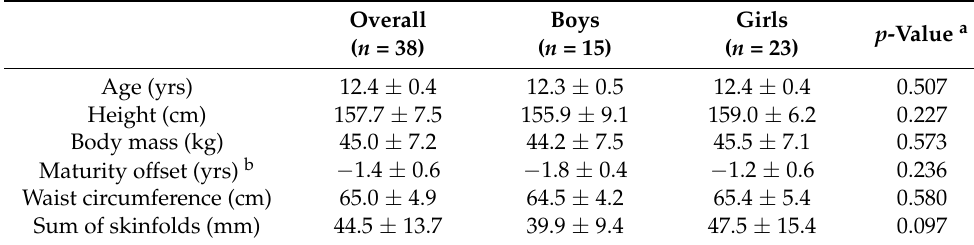
Table 1. Anthropometric